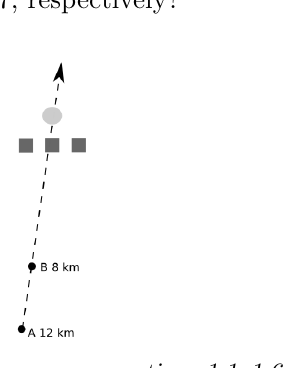
Figure 7: Scenario 1 for survey questions 1.1–1.6 and